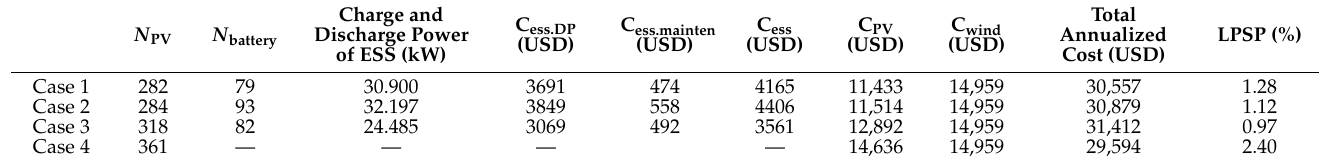
Table 3. Simulation results of four cases for the hybrid